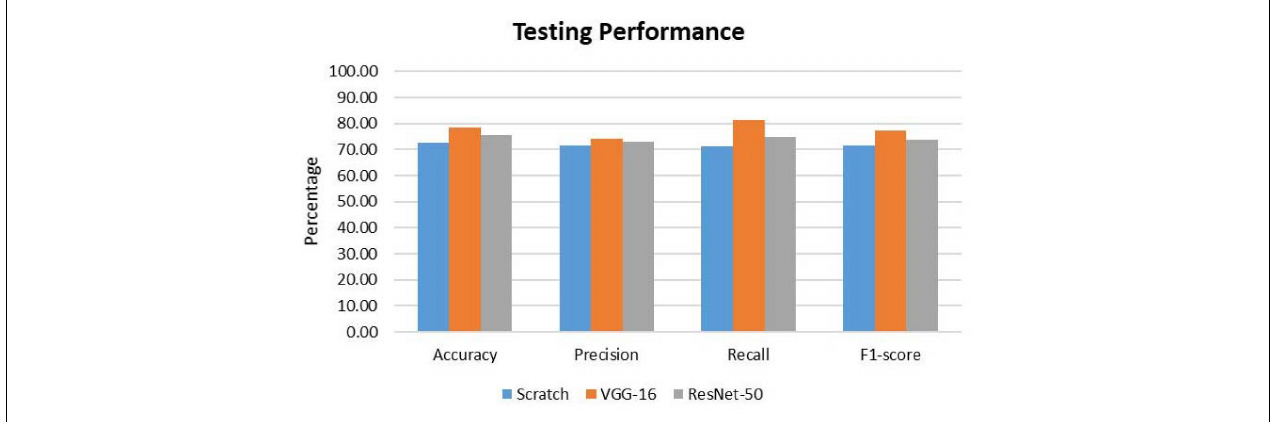
FIGURE 5 | Comparison of classification performance on test data. For all the metrics, VGG-16 ranks the highest.